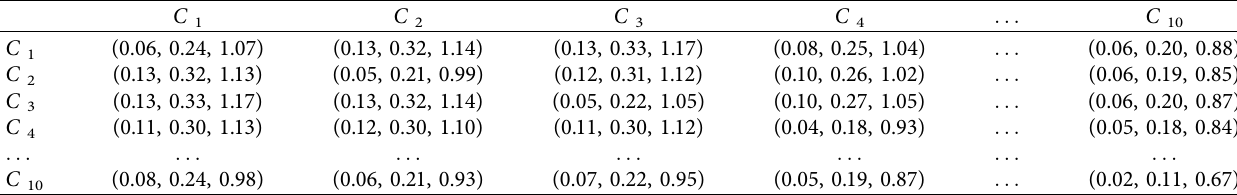
Table 5: Group total influence matrix.